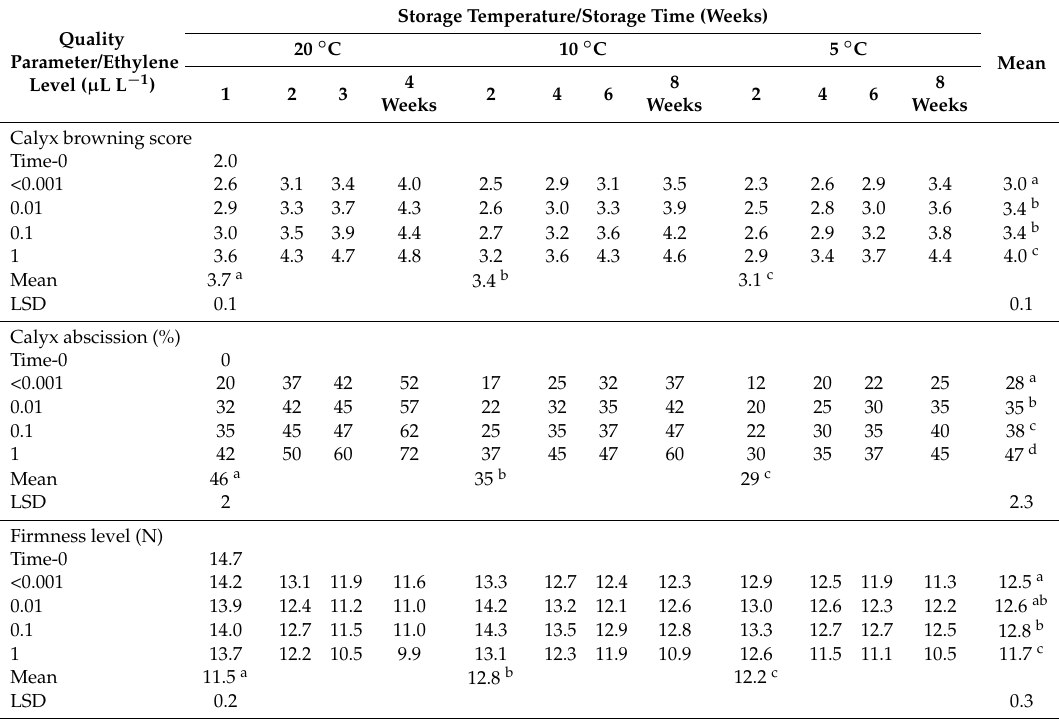
Table 1. Calyx browning, calyx abscission and firmness level in ‘Afourer’ mandarins exposed to different ethylene concentrations and stored at 20, 10 and 5 ◦